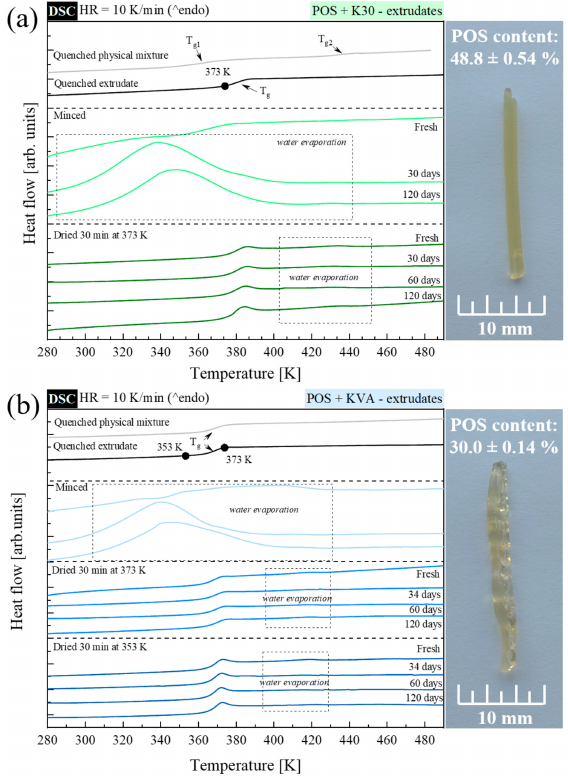
Figure 7. DSC thermograms of ( a ) POS + 50% K30 quenched physical mixture—gray line; quenched extrudate—black line; minced and non-dried extrudate (fresh, and stored for 30 and 120 days)—light green lines; minced and dried for 30 min at 373 K extrudates (fresh, and stored for 30, 60, and 120 days)—dark green lines. DSC thermograms of ( b ) POS + 70% KVA quenched physical mixture— gray line; quenched extrudate—black line; minced and non-dried extrudate (fresh, and stored for 34, and 120 days)—light blue lines; minced and dried for 30 min at 373 K extrudates (fresh, and stored for 34, 60, and 120 days)—intermediate blue lines; and minced and dried for 30 min at 353 K extrudates (fresh, and stored for 34, 60, and 120 days)—dark blue lines. On the right-hand side, POS-based extrudates are